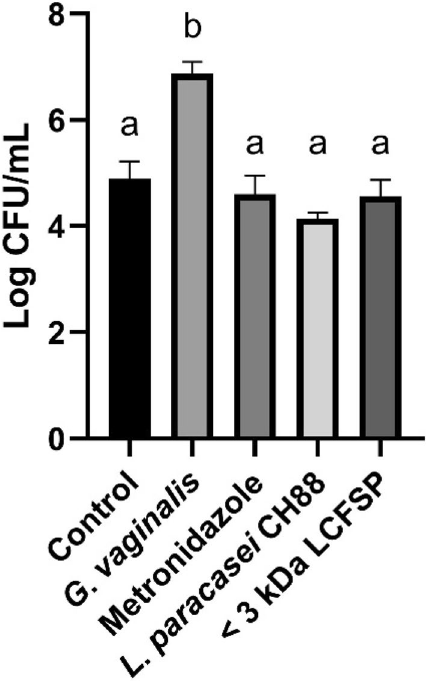
Figure 5. Colony forming unit (CFU) of Gardnerella vaginalis in vaginal fluid of the mice intravaginally treated with phosphate-buffered saline (20 μL), G . vaginalis (1 × 10 8 CFU), metronidazole (100 μg), Lactobacillus paracasei CH88 (1 × 10 10 CFU), and protein fraction below 3 kDa of L. paracasei CH88 cell-free supernatant (20 μg; < 3 kDa LCFSP). Bars are means and standard errors of the means (n = 6). Different small letters indicate significant differences ( p < 0.05; one-way ANOVA and Duncan’s multiple range test).